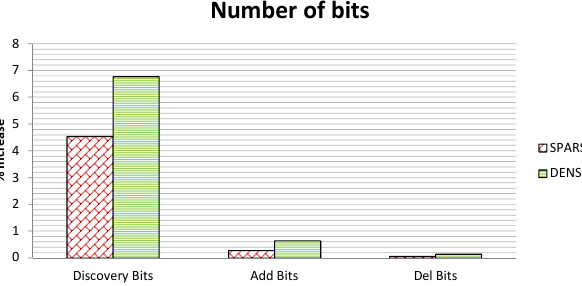
Figure 14. Discovery Bits, Add Bits and Del Bits in Sparse and Dense